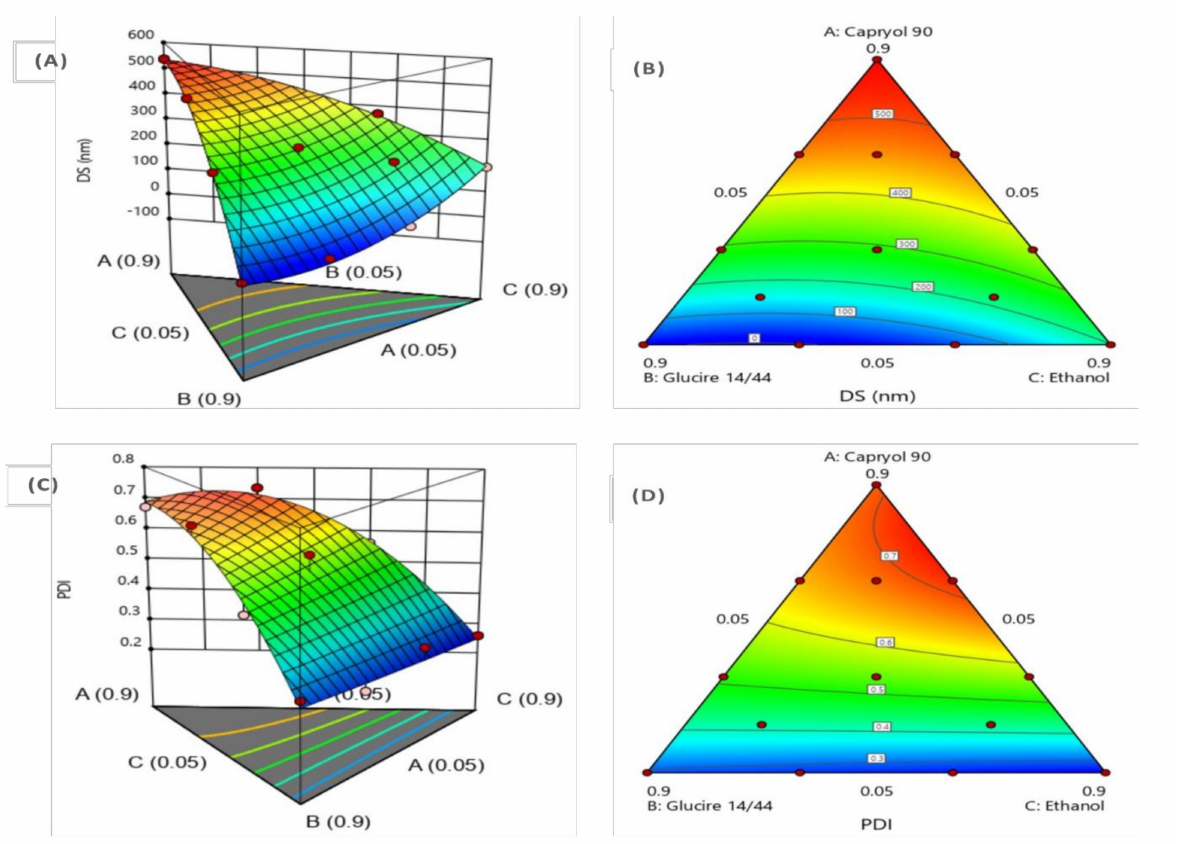
Figure 5. Response surface plots for the effect of Fr-SNEDS compositions (Capryol™ 90, Gelucire ® 44/14, and Ethanol): ( A , B ) on droplet size (DS) and ( C , D ) on poly dispersity index